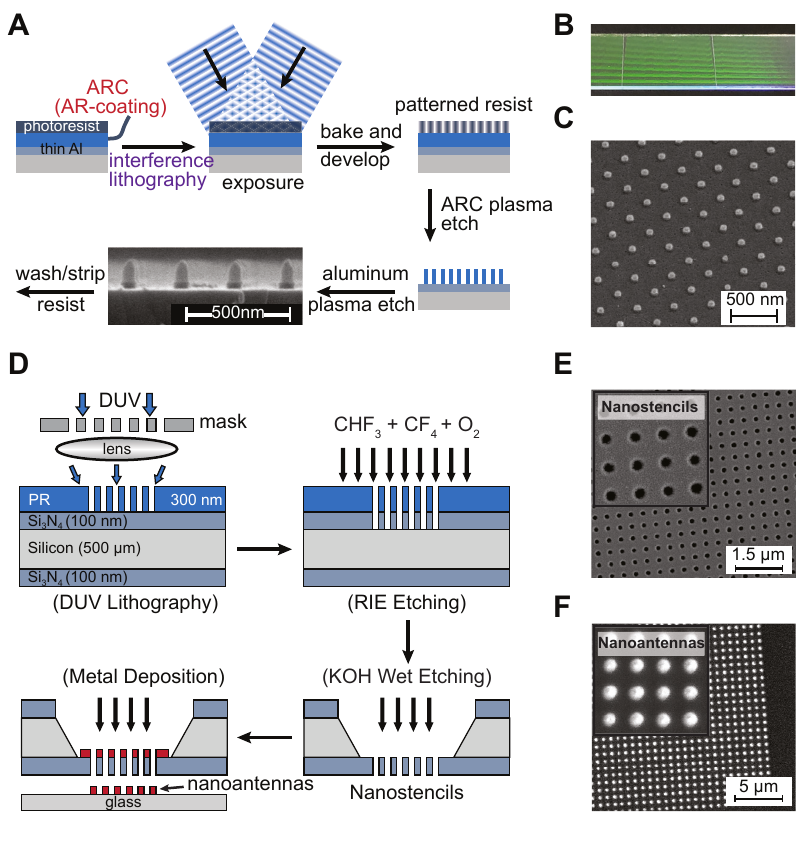
Figure 4: High-throughput and wafer-scale fabrication of PNAs: (A) Schematic of the DUV nanofabrication approach enabling